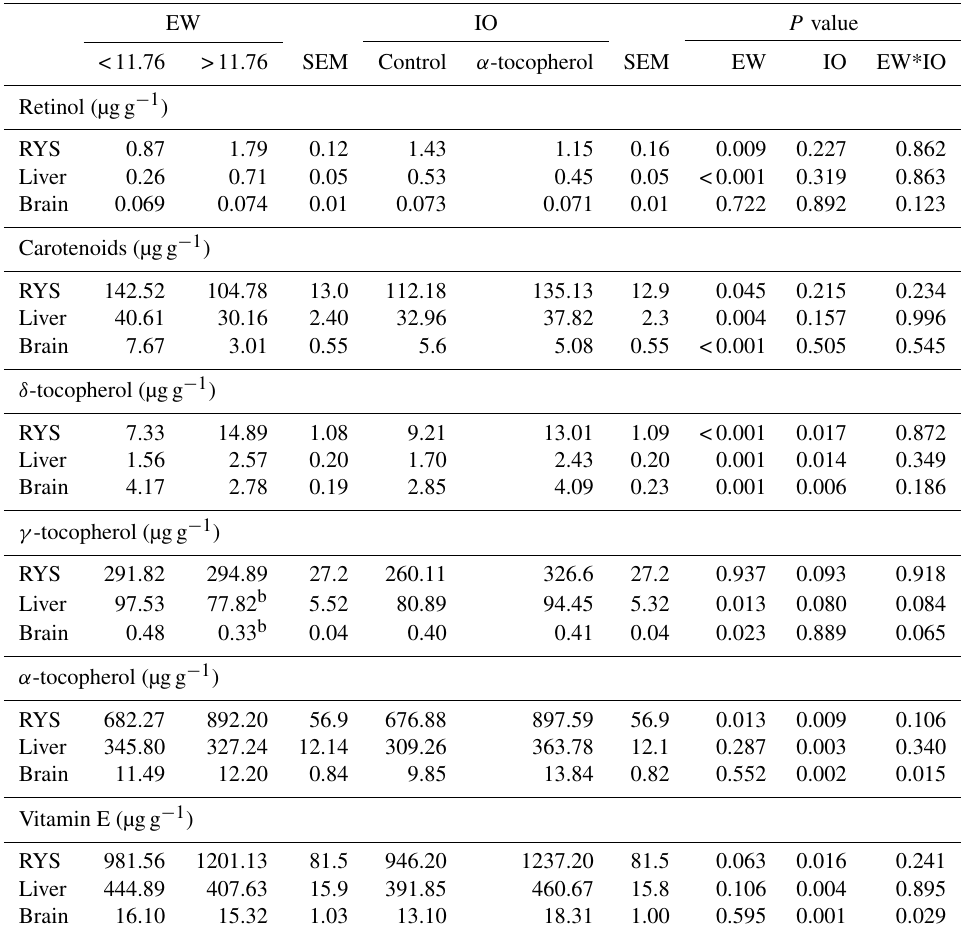
Table 4. The effects of egg weight and in ovo administration of α -tocopherol on the concentrations of total retinol, total carotenoids, δ -, γ -, and α -tocopherols, and vitamin E in the residual yolk sac, liver and brain of the quail chick. EW IO P